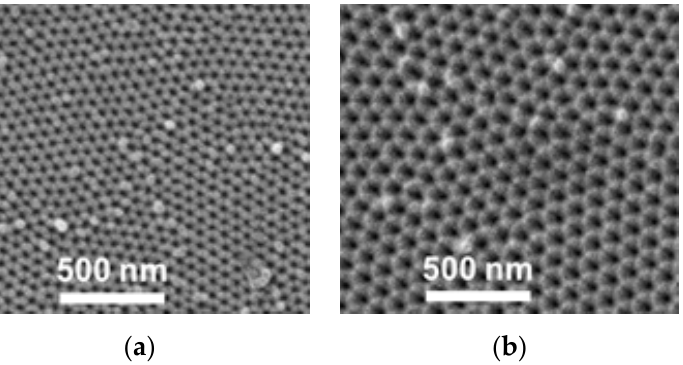
Figure 1. SEM micrograph of: ( a ) Sf-NPAM/TiO 2 membrane surface and ( b ) Ox-NPAM/TiO 2 membrane surface (values and reference in text).